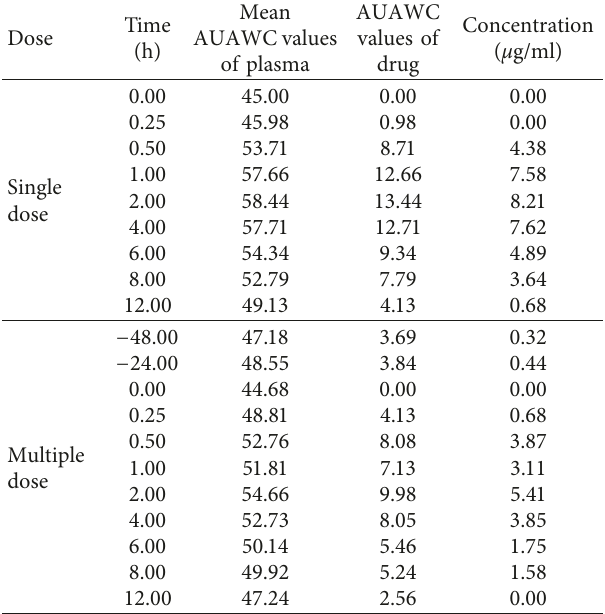
Table 4: The mean values of AUAWC and concentrations of total components ( n 8). (cid:31)